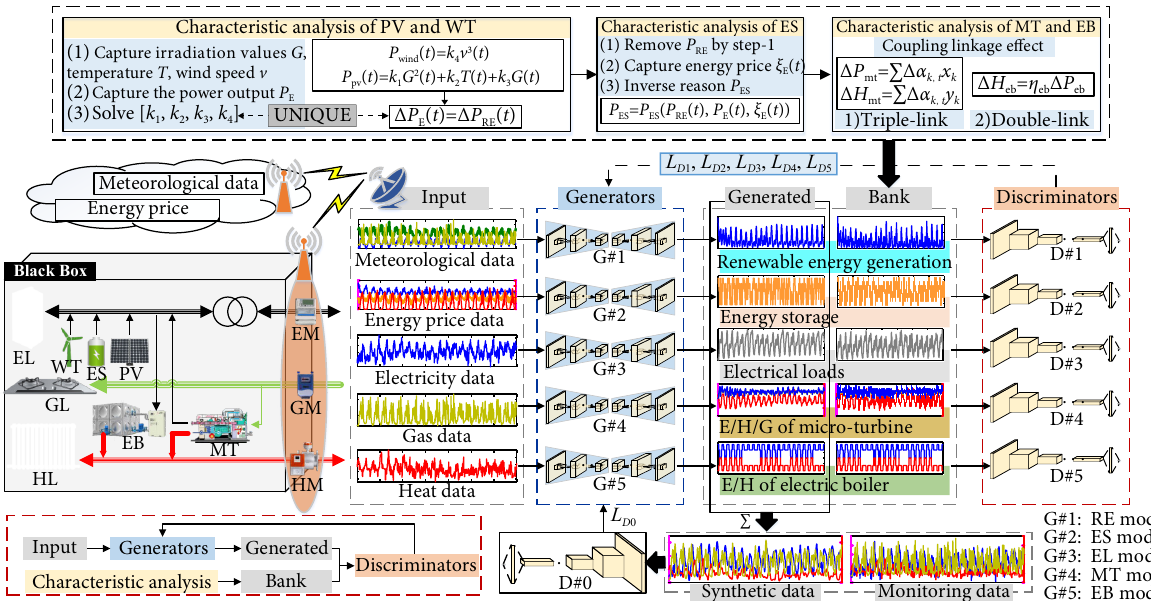
Fig. 1 Schematic diagram of the preposed non-intrusive modeling